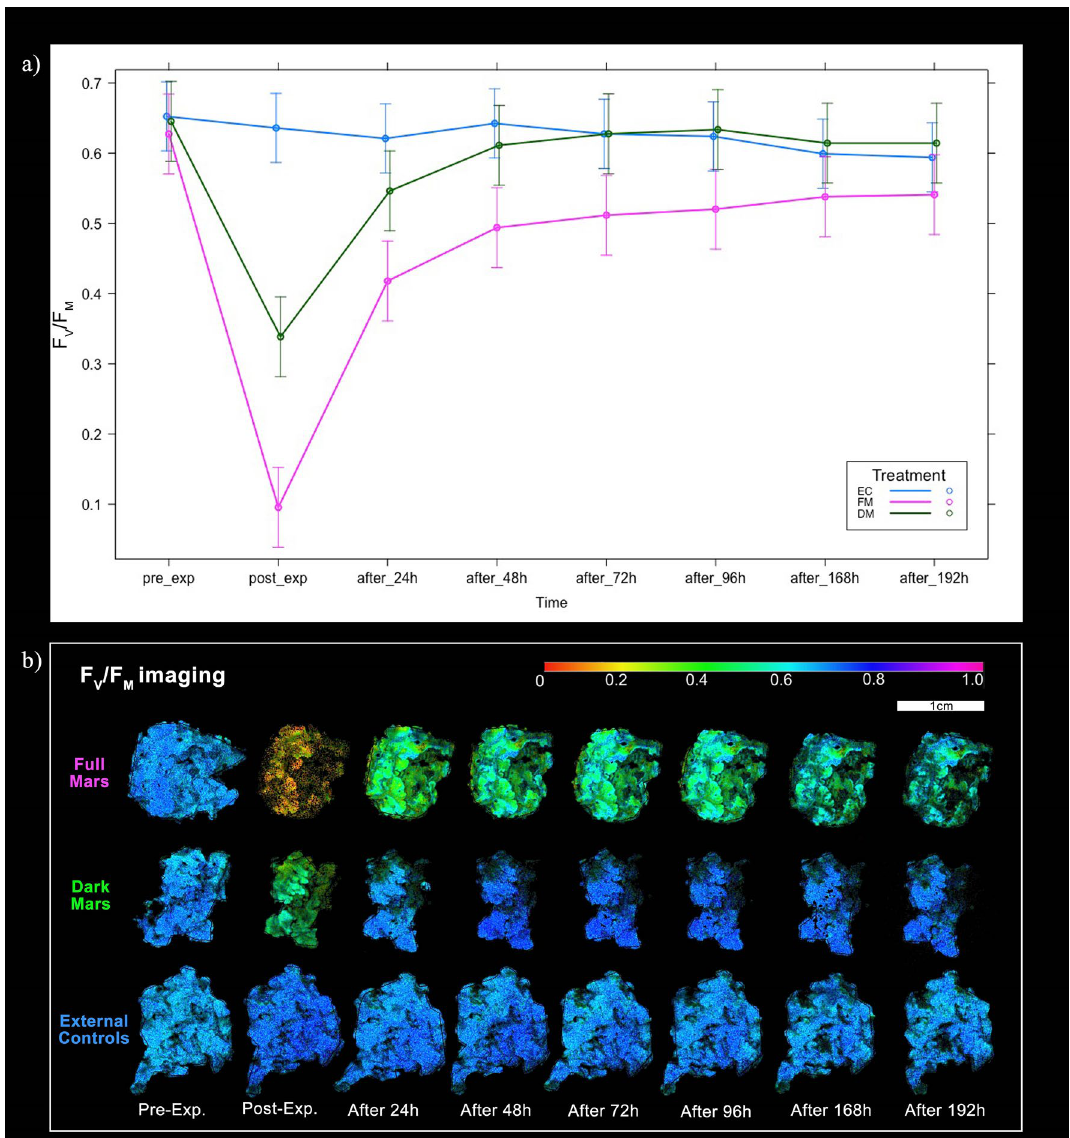
Figure 5. ( a ) Variation of the PSII (Y = F V /F M ) efficiency before (pre_exp), after (post_exp) and 24 h, 48 h, 72 h, 96 h, 168 h and 192 h after the treatment. Blue line = external control, EC; magenta line = full Mars, FM; green line = dark Mars, DM. Error bars stands for confidence intervals. See Table S3 for ANOVA results. ( b ) Fluorescence (F V /F M ) imaging of three samples’ treatments (Full Mars, Dark Mars and External Controls) before (pre-exp.), after (post-exp.) and 24 h, 48 h, 72 h, 96 h, 168 h and 192 h after the treatment performed with Imaging PAM instrument. After simulation, small segments for TEM observations and Raman spectroscopy were cut from Full Mars and Dark Mars samples. Lichen material size and color bar values’ legend is reported on the bottom right of the